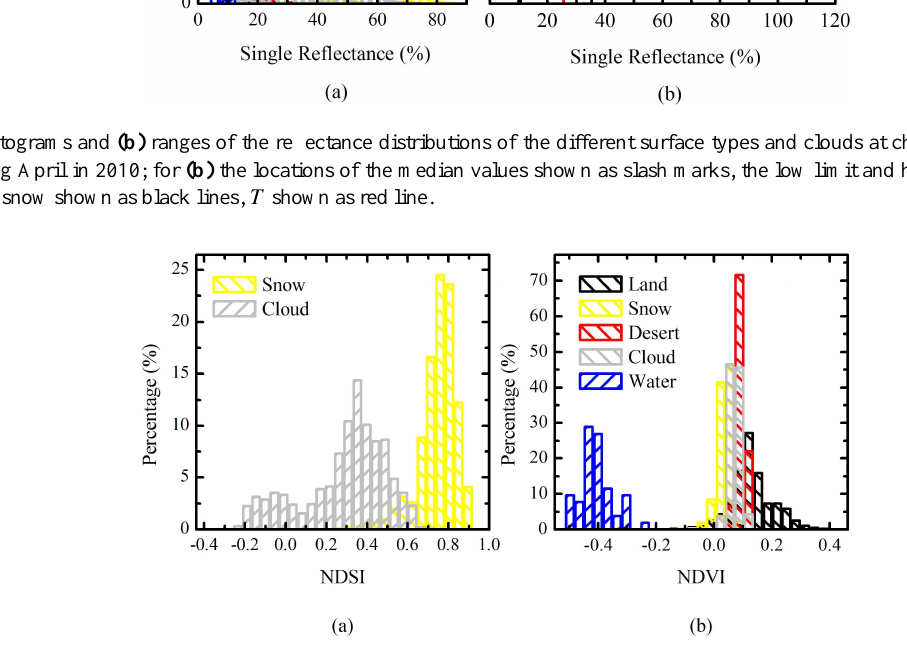
Fig. 3. Histograms of (a) NDSI and (b) NDVI distributions during January in 2010.